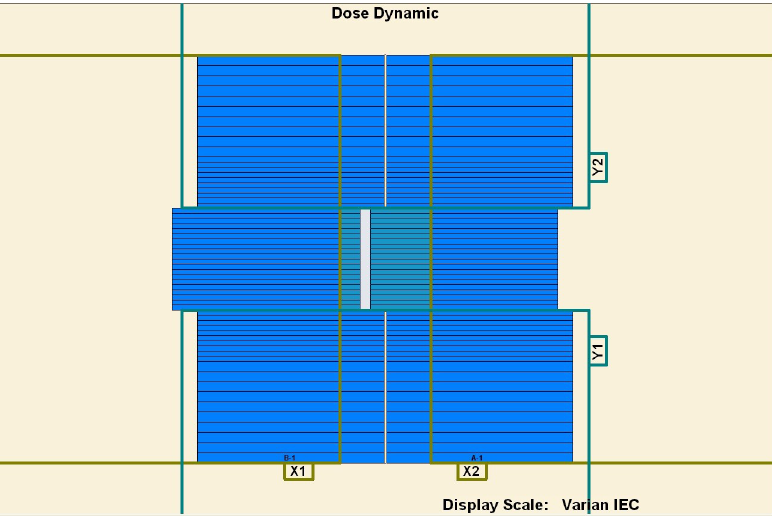
Fig 2. Five segments designed to be 1 × 10 cm 2 . (1) First segment’s center: − 4 cm. (2) Second segment’s center: − 2 cm. (3) Third segment’s center: 0 cm. (4) Fourth segment’s center: 2 cm. (5) Fifth segment’s center: 4